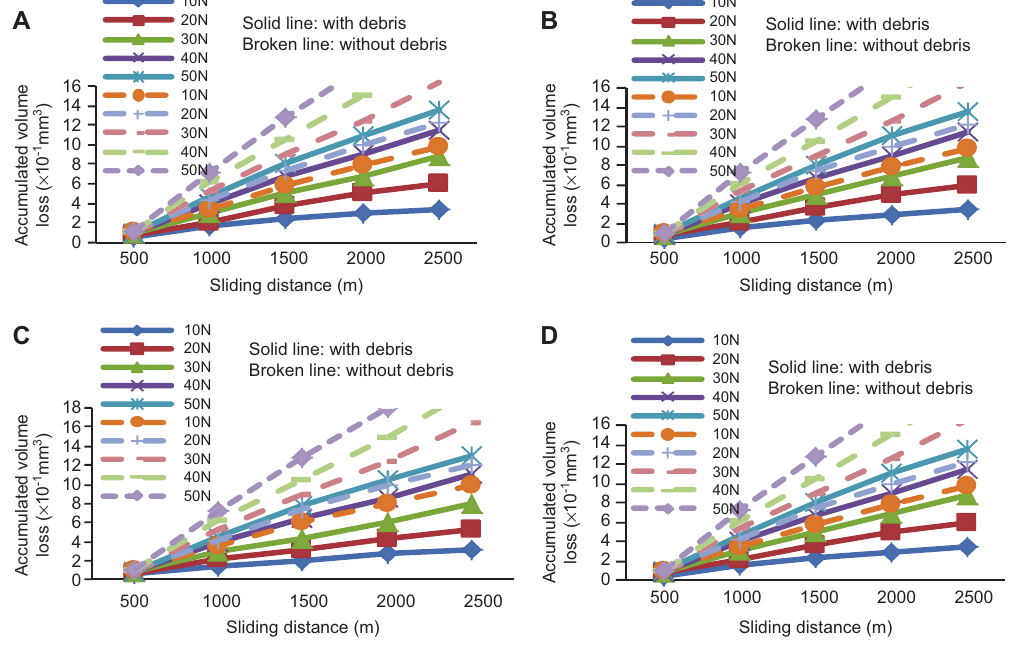
Figure 4 Variation of the accumulated volume loss with sliding distance for the composites designated as (A) 0.5 wt% , (B) 1.5 wt% , (C) 2.5 wt% , (D) 3.5 wt% TiO tested at different loads with (broken line) and without (solid line) the removal of wear debris during the 2